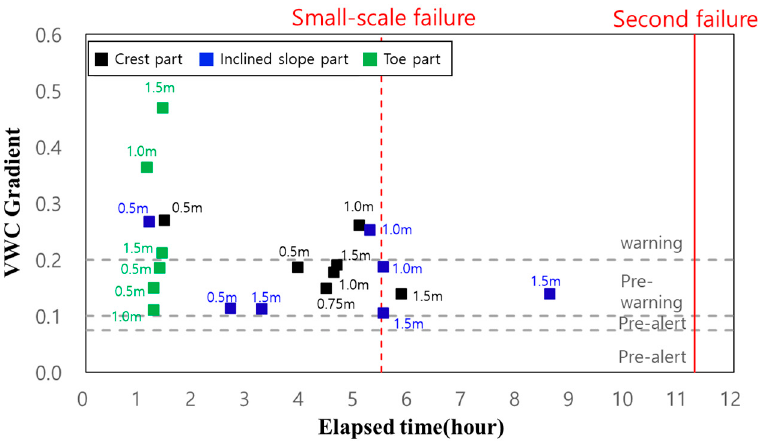
Figure 15. Variation of the VWC gradient as a function of time (first experiment).